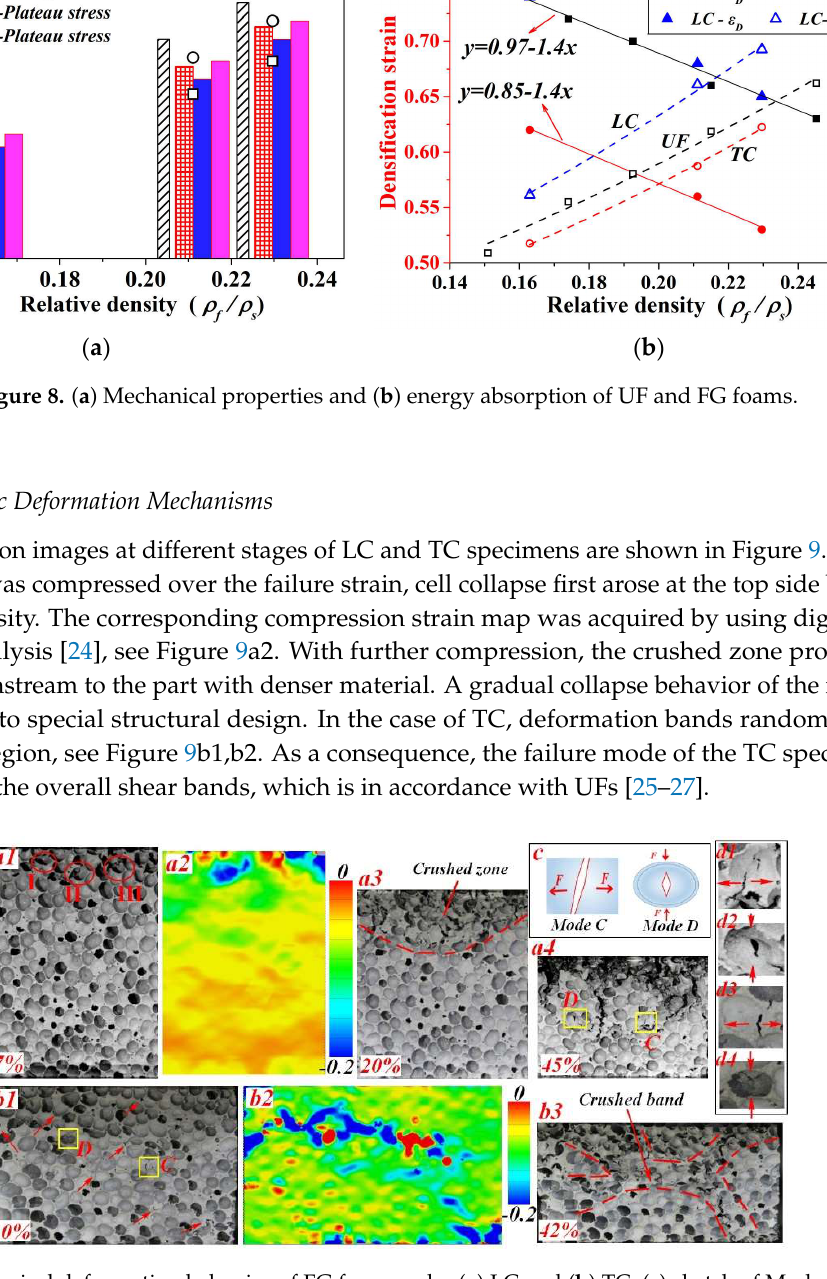
( b ) Figure 7. ( a ) Compressive strength of UF and FG aluminum foams and ( b ) anisotropy parameter. In the case of TC, materials with different densities experienced the same deformation rate. The strength can be calculated by averaging the load sharing of each section in the specimen. The transverse compression strength of aluminum foams can be predicted by taking cell shape anisotropy into consideration [17,19]. For three groups of FGs, the cell shape anisotropy parameter R at different depths of the specimen was measured and illustrated in Figure 7b. As we can see, the cell shape